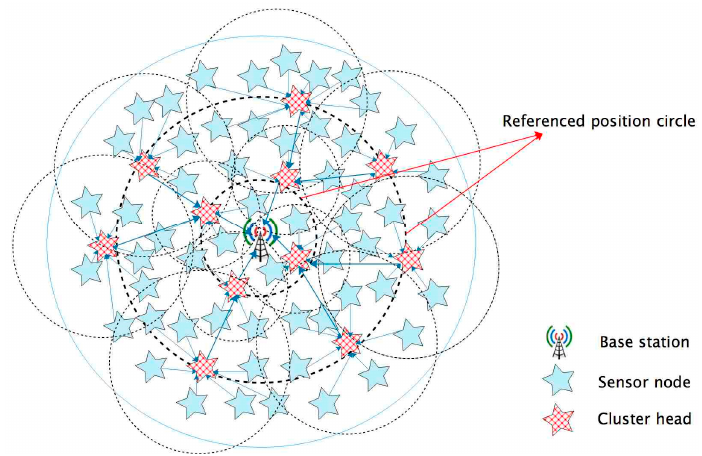
Figure 1. An overview of the FTUC protocol including the ’referenced position circles’ to elect evenly the CHs.